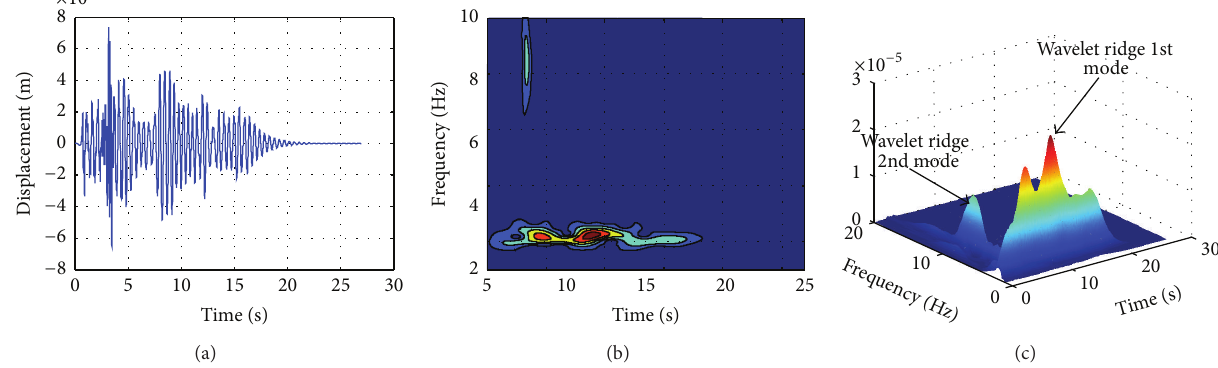
Figure 7: (a) The displacement response at top story level, (b) its time-frequency plot, and (c) wavelet ridges.